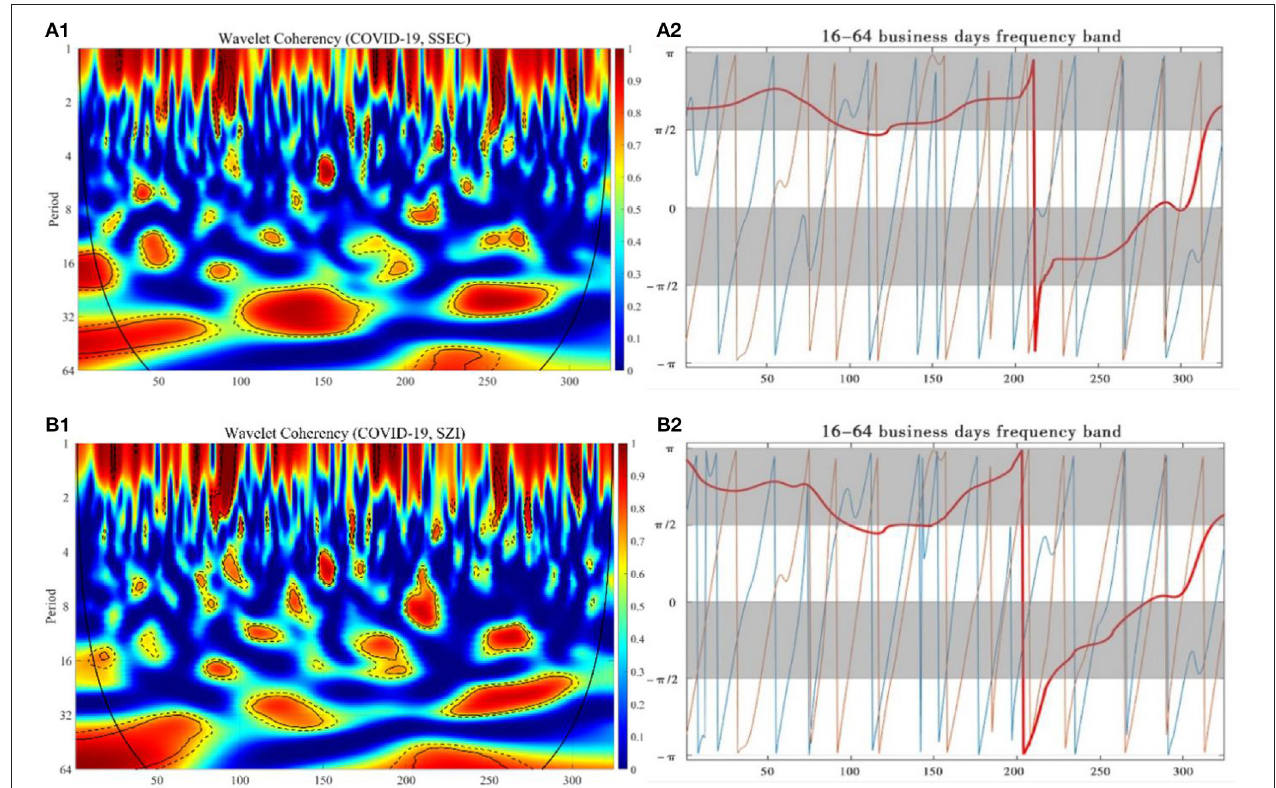
FIGURE 3 | The wavelet coherence and phase difference between daily COVID-19 new cases in China and SSEC, SZI. Wavelet coherence ( A1,B1 ) and phase difference ( A2,B2 ).